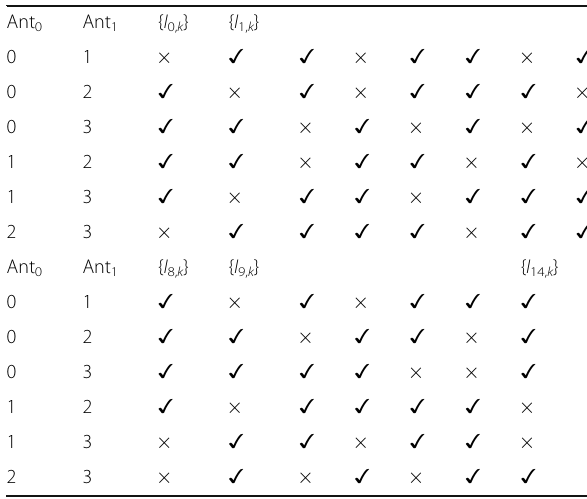
Table 1 TAC-sets for GSM with N t = 4, N a = 2 Ant 0 Ant